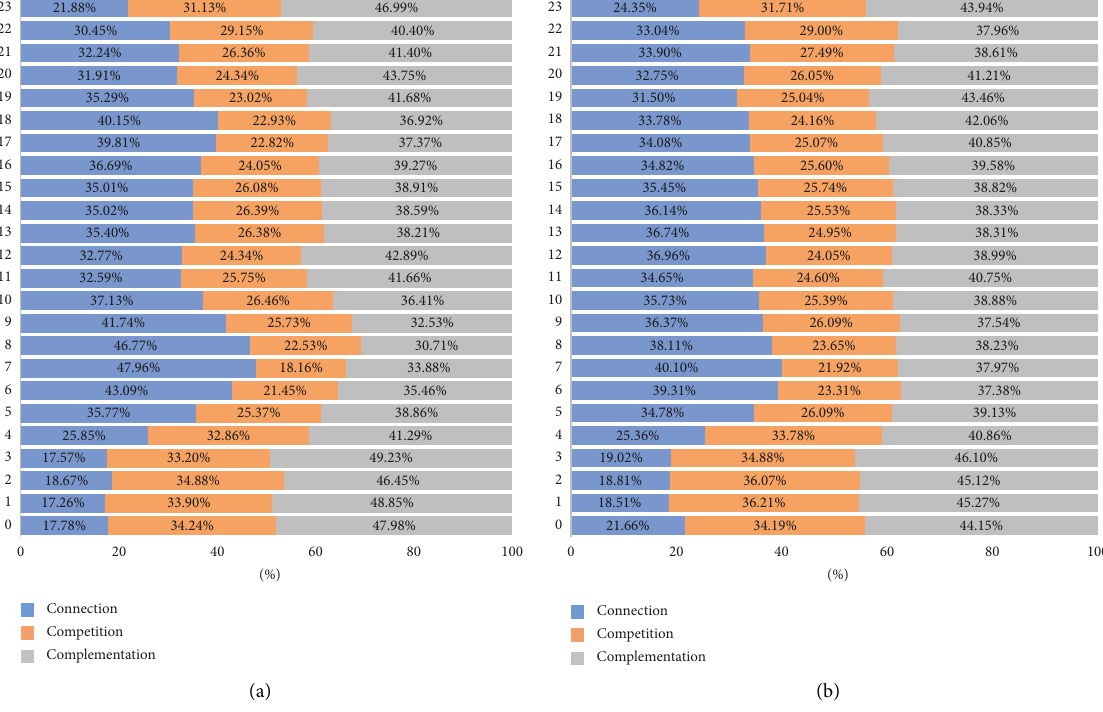
Figure 10: The hourly variation of the share of connection, complementation, and competition trips. (a) Weekday. (b)